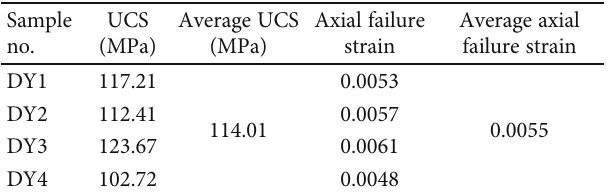
Figure 1: Rock sample preparation and the testing system. Table 1: Uniaxial compressive strength and axial strain of